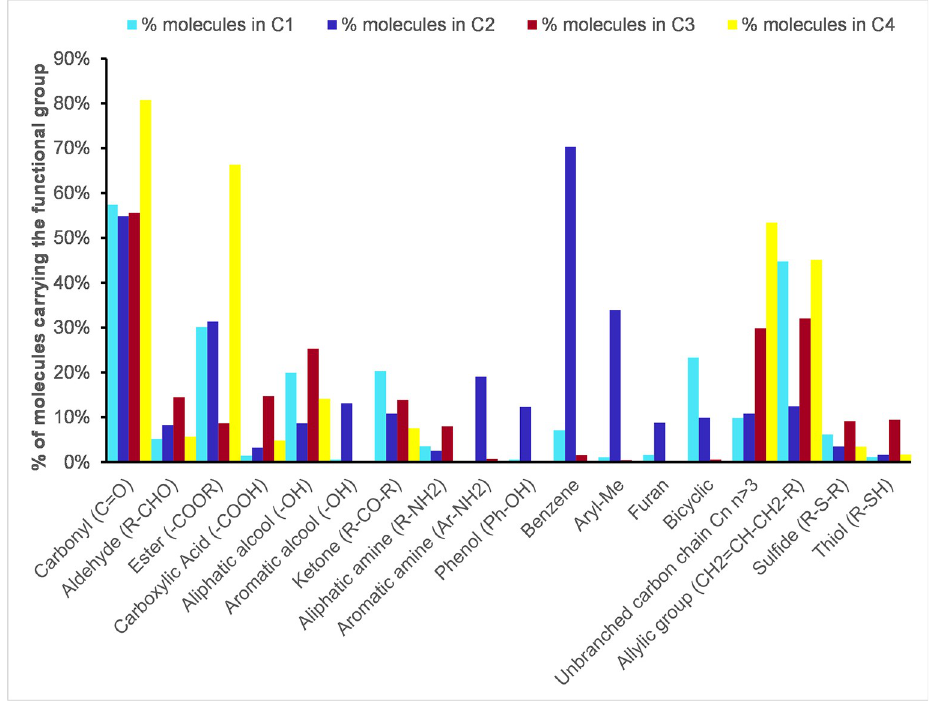
Fig 6. Histogram of the distribution of the chemical functional groups according the clusters. Only the structures present in at least 5% of the molecules of one of the 4 clusters C1, C2, C3 and C4 are represented: C1 in light blue; C2 in dark blue; C3 in dark red; C4 in